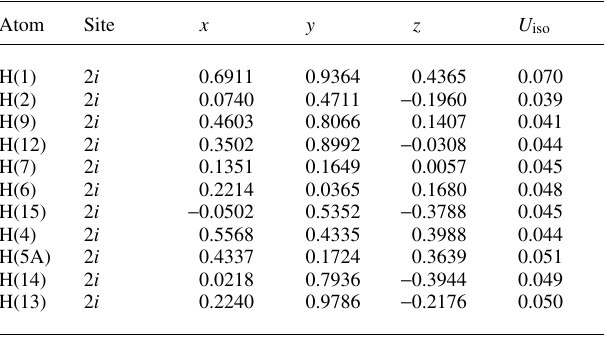
Table 2. Atomic coordinates and displacement parameters (in Å 2 )